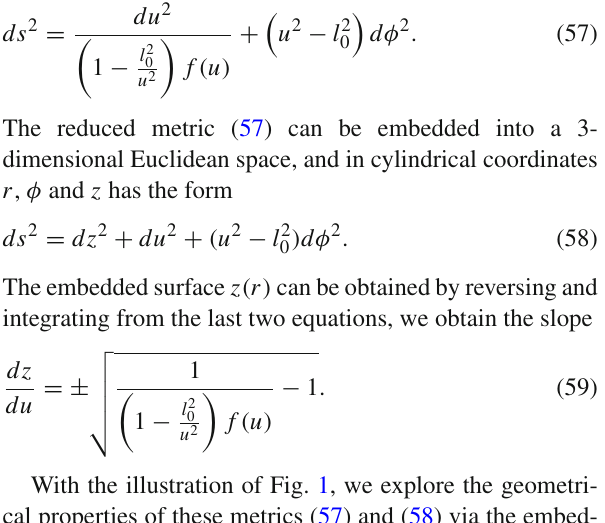
where a gives the constant plate separation. The total stress- energy tensor (SET) for such a case could be